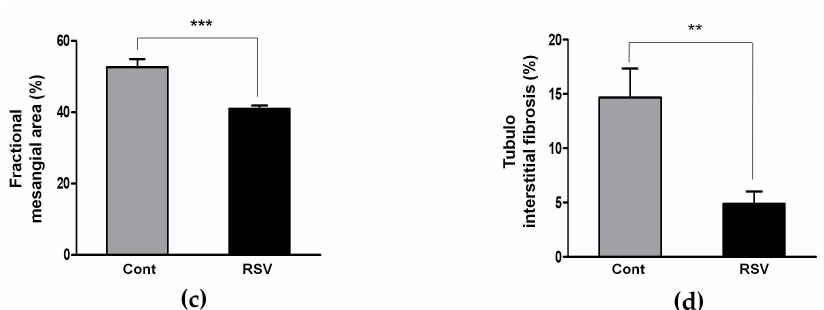
Figure 2. Effects of resveratrol on aging-related histological renal injury. ( a ) Representative photomicrographs of the periodic acid–Schiff-(PAS)-stained kidney showed less expansion of the mesangial area in the RSV group (original magnification 400 × ). ( b ) Representative sections of the Masson’s trichrome-stained kidney showed significantly less tubulointerstitial fibrosis in the RSV group (original magnification 200 × ). ( c ) Quantitative assessments of the areas of extracellular matrix in the glomerulus. ( d ) Quantitative assessment of the areas of tubulointerstitial fibrosis in the control and RSV groups (** p < 0.01, *** p < 0.001).